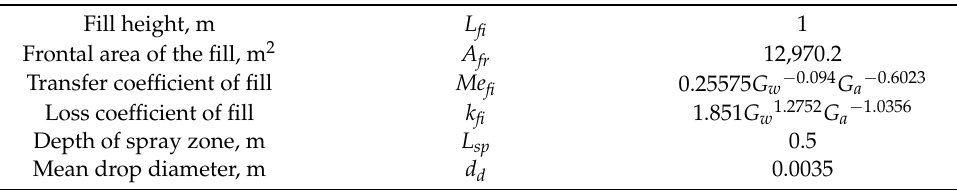
Table 4. Detailed parameters of the packing fill.